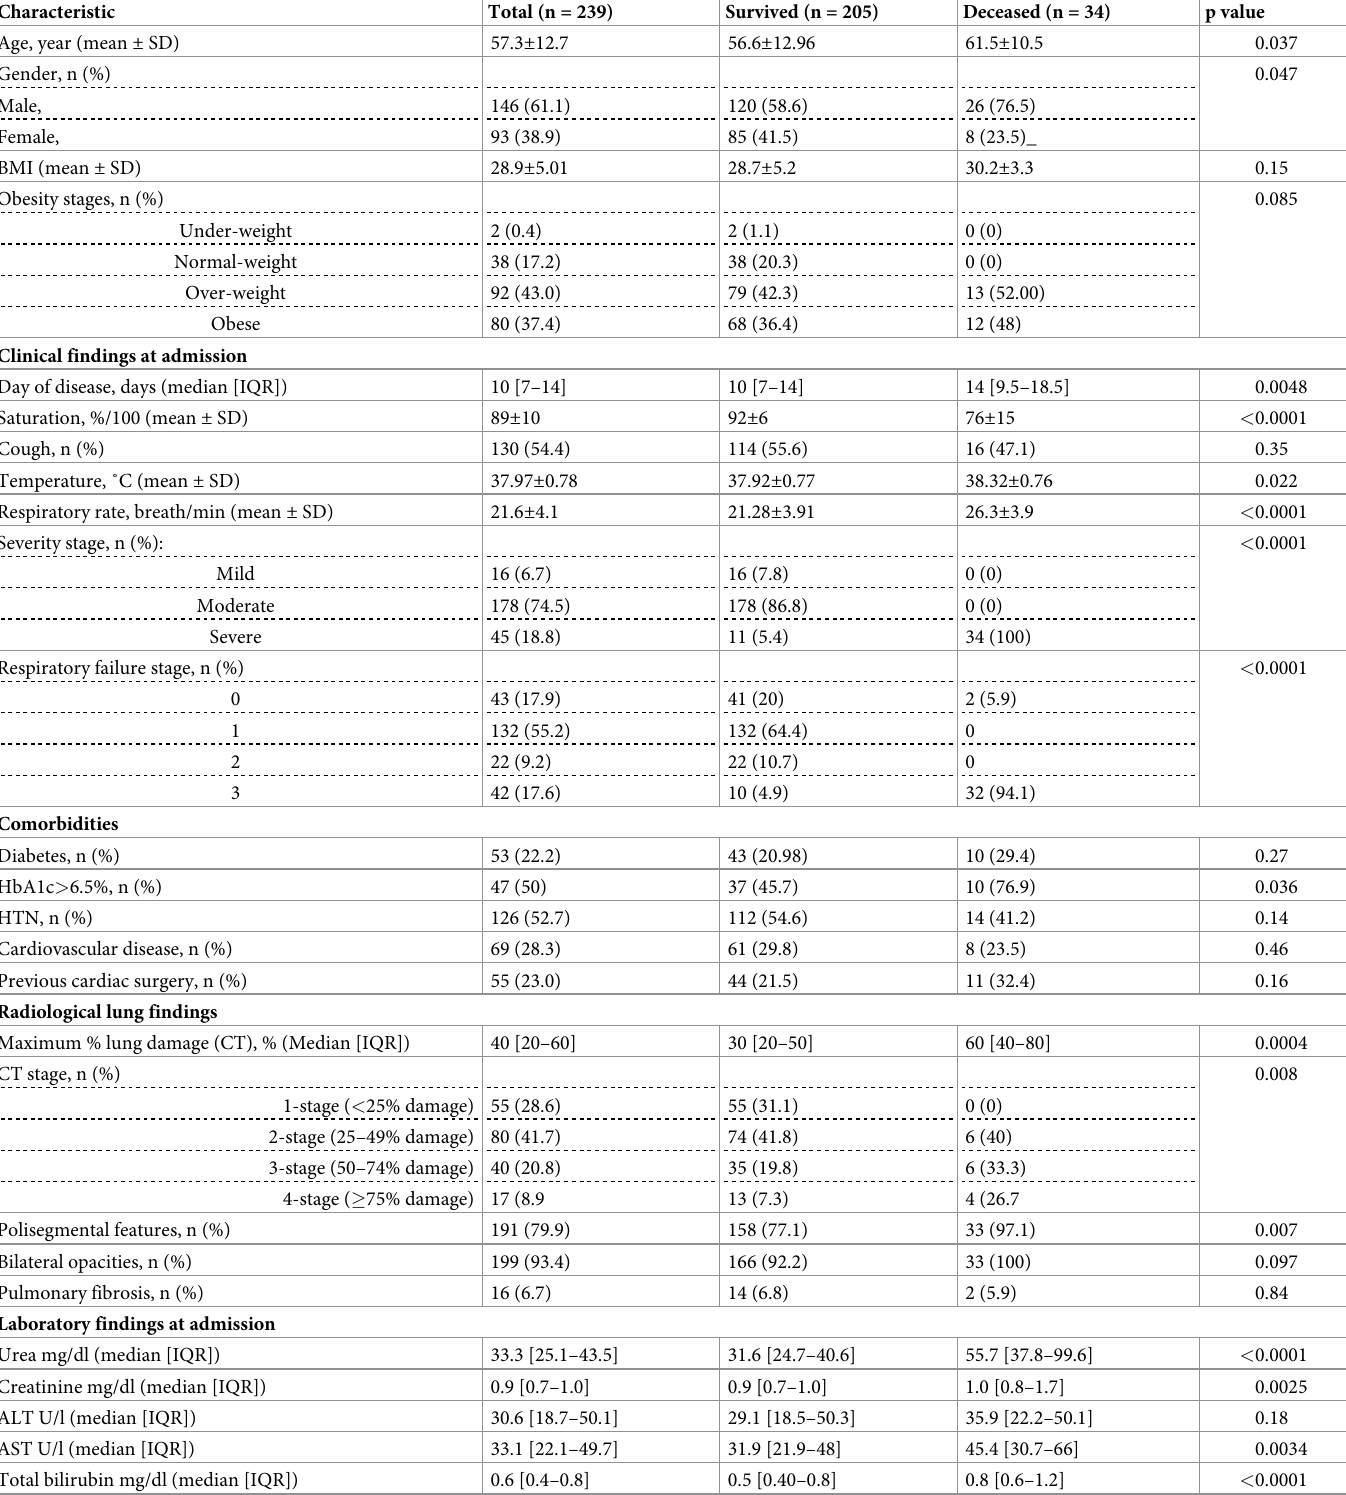
Table 1. General characteristics of admitted COVID-19